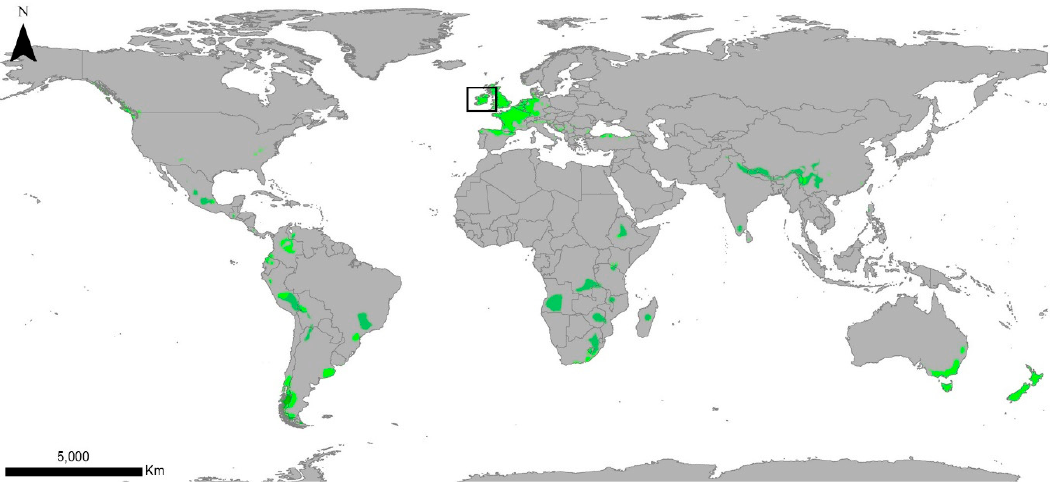
Figure 1. World map of the temperate oceanic climate zones (in green, modified from [15] ). Location of Ireland is marked by the black rectangle.